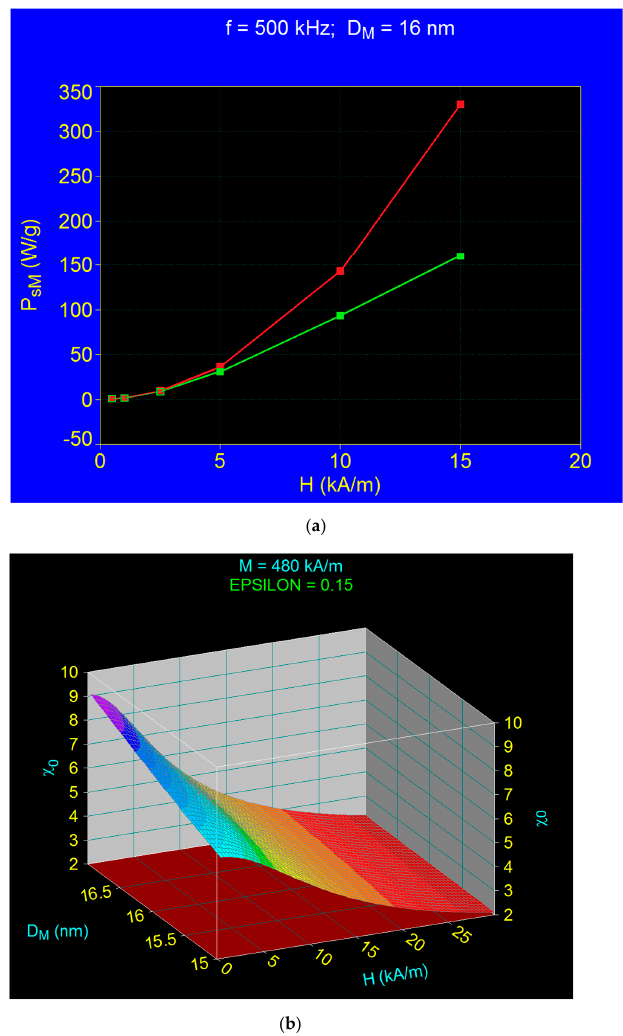
Figure 5. ( a ) Maximum specific loss power ( P sM ) variation as a function of the amplitude of magnetic field H , calculated by Equation (17) (red curve) and Equation (22) (green curve), for nanoparticle diameter of 16 nm (corresponding to maximum power) and AMF frequency of 500 kHz; ( b ) The variation of the static magnetic susceptibility with the magnetic field for different values of the diameter of magnetic nanoparticles that give the maximum specific loss power.